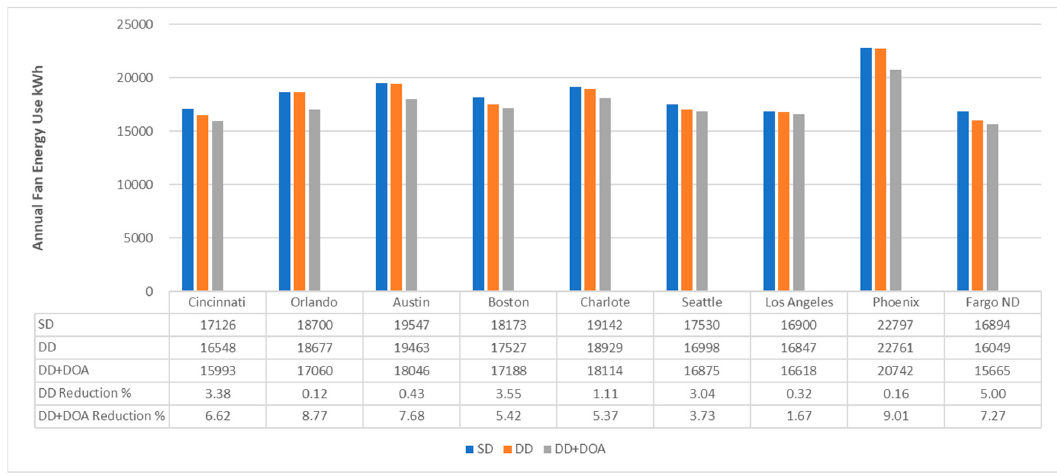
Figure 9. Annual fan energy use for three cases and reduction by using the proposed system.